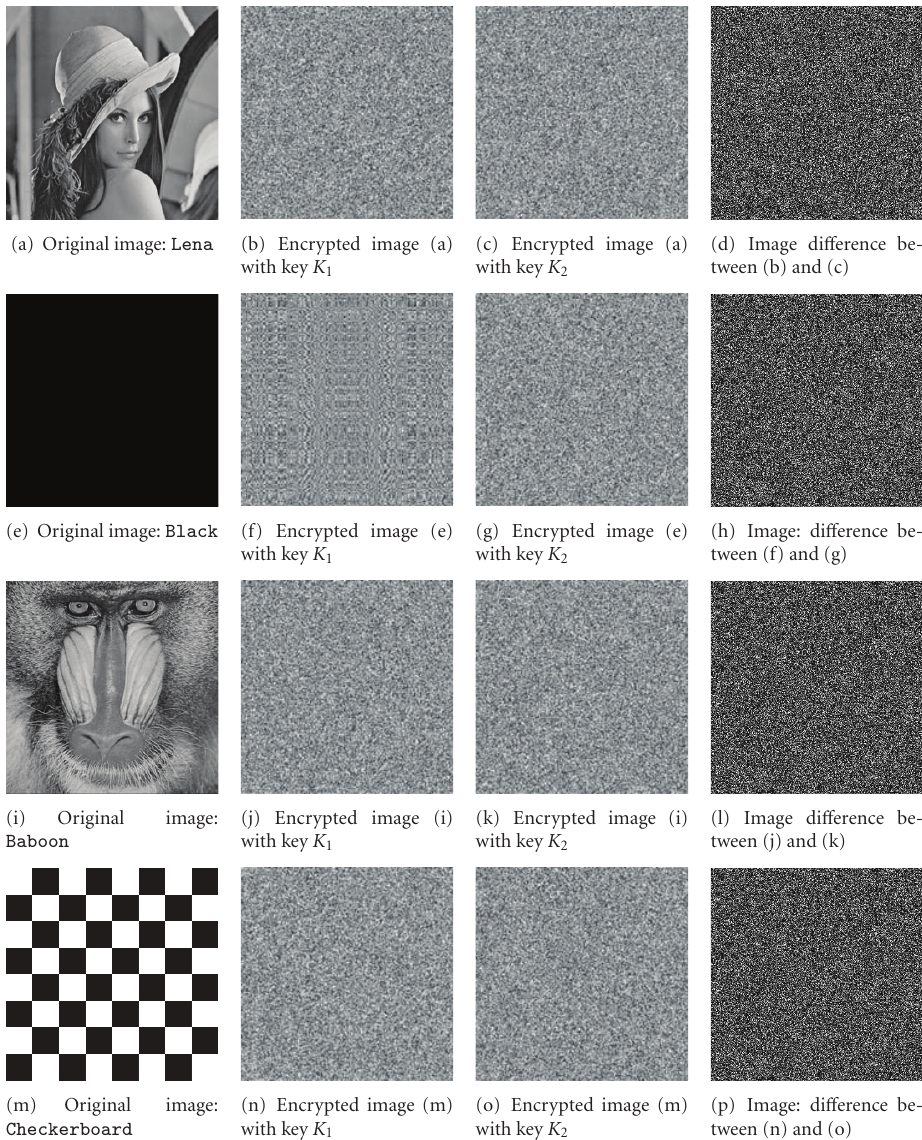
Figure 2: Key sensibility for image encryption using the proposed